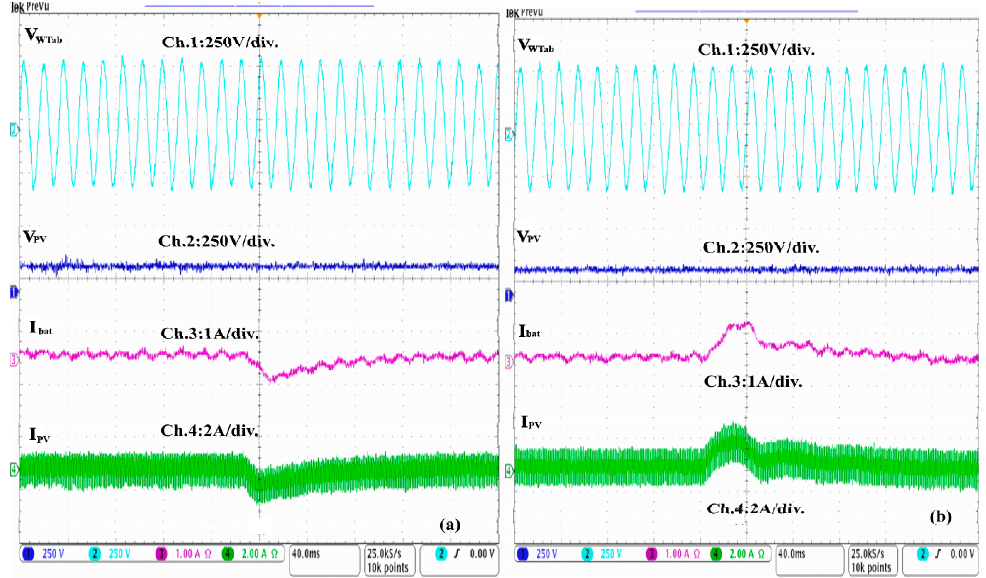
Figure 14. Performance of WT-SPVA based off-grid system with ( a ) decrease in solar irradiation, and ( b ) increase in solar irradiation.